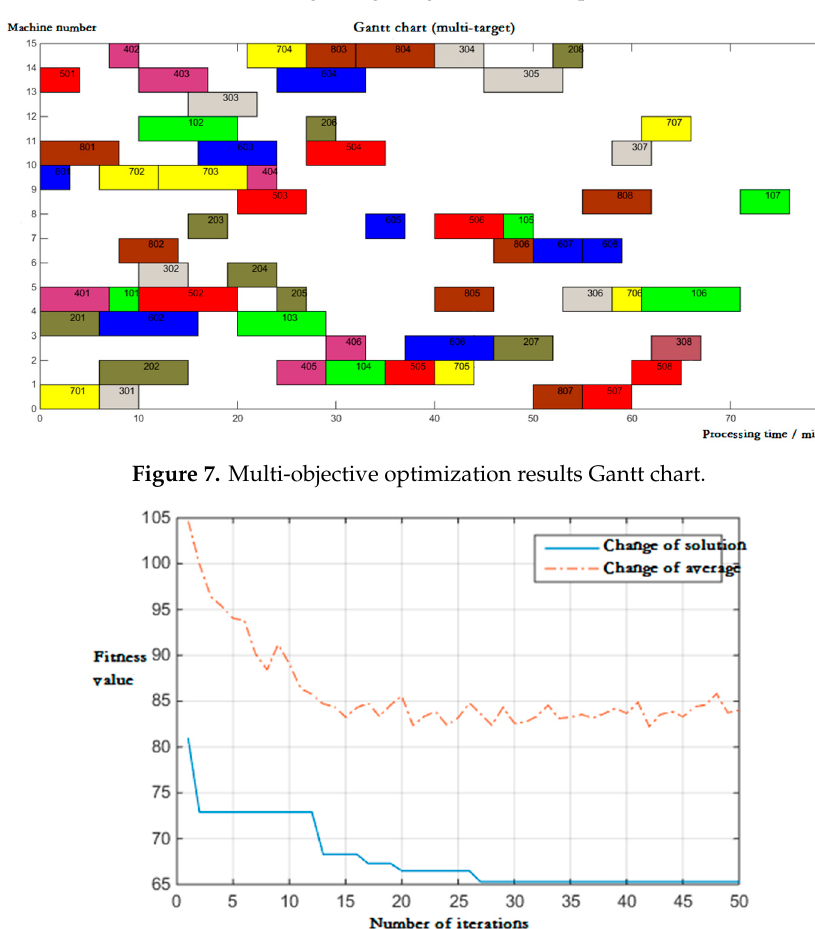
Figure 7. Multi-objective optimization results Gantt chart.